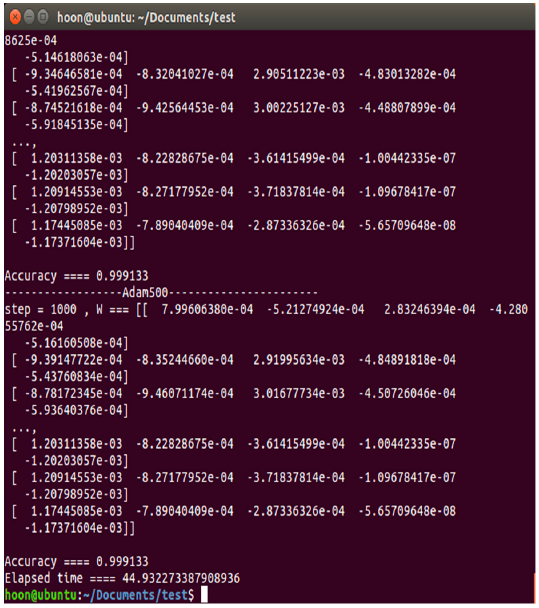
Figure 17. Scenario 3 experiment result: noise learning (G-Descent ⇒ Adam).